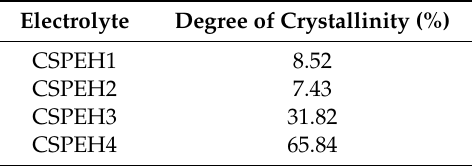
Table 1. The degree of crystallinity from deconvoluted XRD